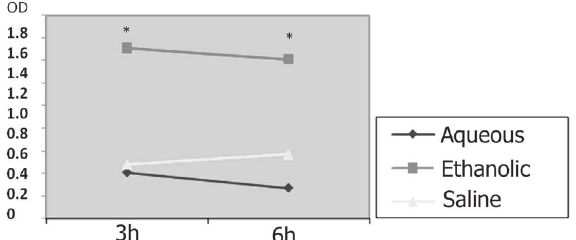
Figure 1- Mean values of edema on both time period and the experimental